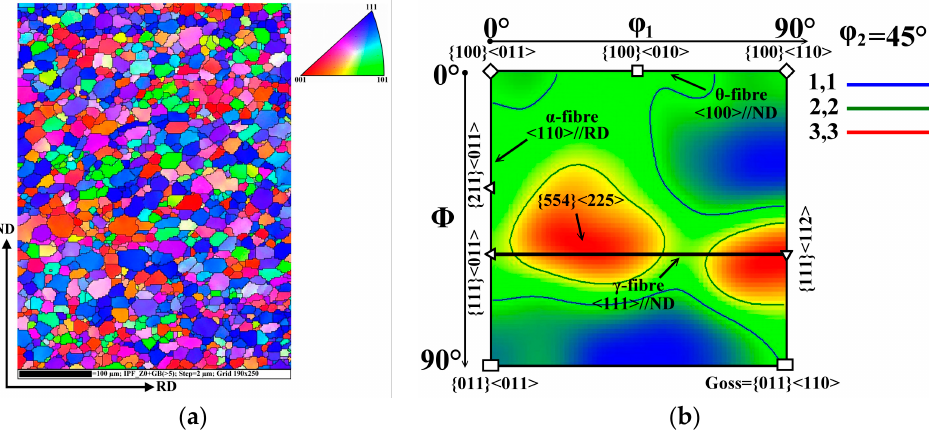
Figure 6. Characterization of the textural state of experimental steel in initial semi-finished state: IPF map ( a ) and ODF section taken at ϕ 2 = 45° ( b ). The key for the identification of crystallographic orientation of grain is located in the upper right corner of the IPF map.